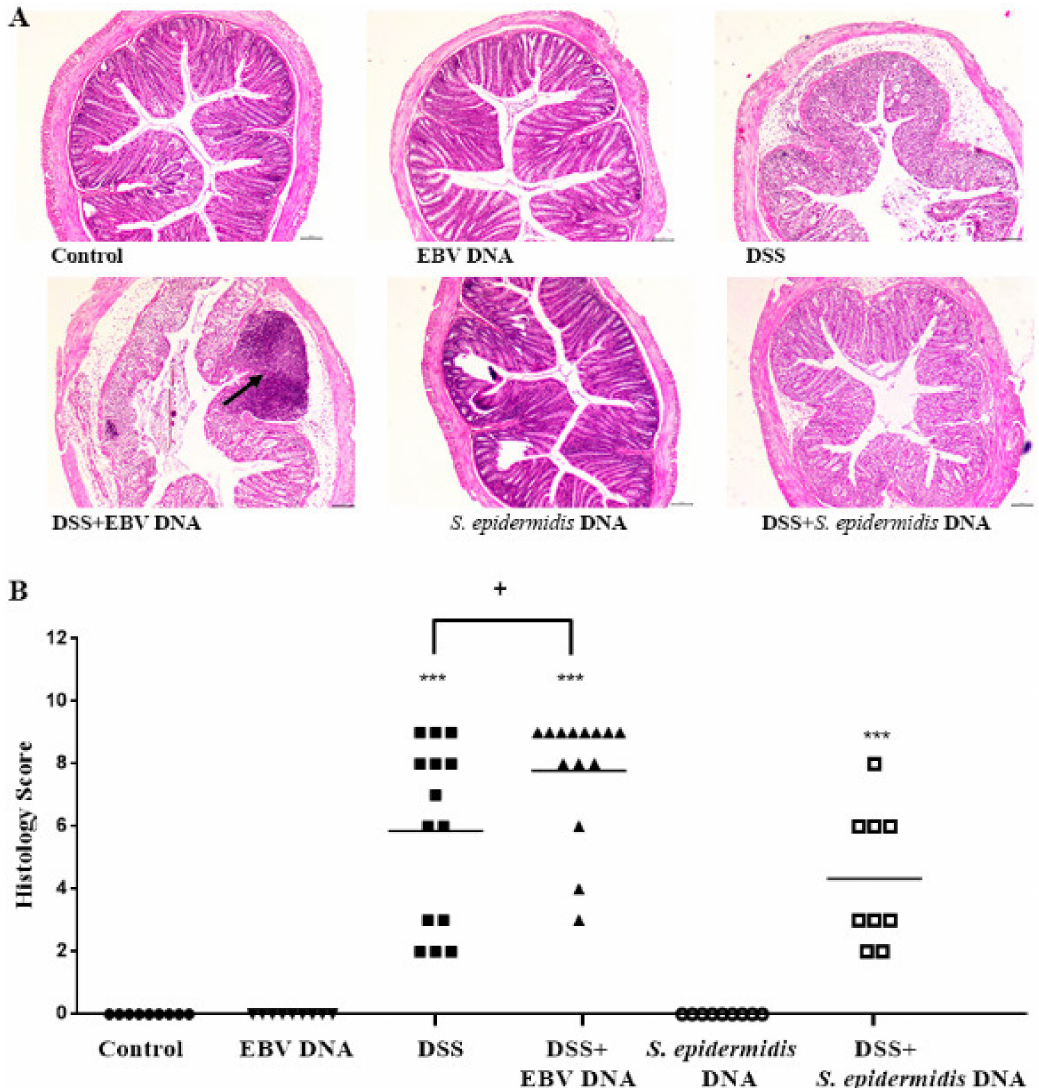
Figure 5. Histological damage in control and experimental mouse groups used to assess the effect of Epstein–Barr virus (EBV) DNA on colitis severity in C57BL/6J mice. C57BL/6J mice ( n = 9–14 per group) received either 1.5% dextran sodium sulfate (DSS)-containing or regular drinking water for 7 days. Three DSS-treated groups were then rectally administered sterile water, Epstein–Barr virus DNA in sterile water or S. epidermidis DNA in sterile water on day 3. The other normal drinking water-fed groups were included as controls and also received sterile water, EBV DNA or S. epidermidis DNA by rectal gavage on day 3. On day 7 of the experimental protocol, mice were sacrificed, and their colons were collected. ( A ) Hematoxylin and eosin-stained distal sections of mouse colons. Arrow indicates an abscess. ( B ) Mouse group histology scores. Individual mouse scores and average group scores are indicated. *** p < 0.001, compared to the control group; + p < 0.05, compared to the DSS